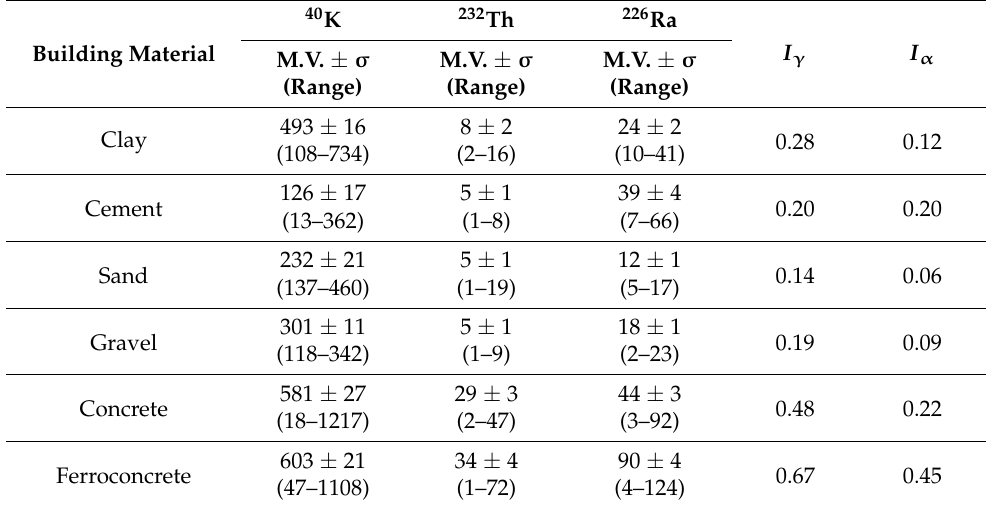
Table 2. Activity concentrations of 40 K, 232 Th, 226 Ra in studied building materials and activity